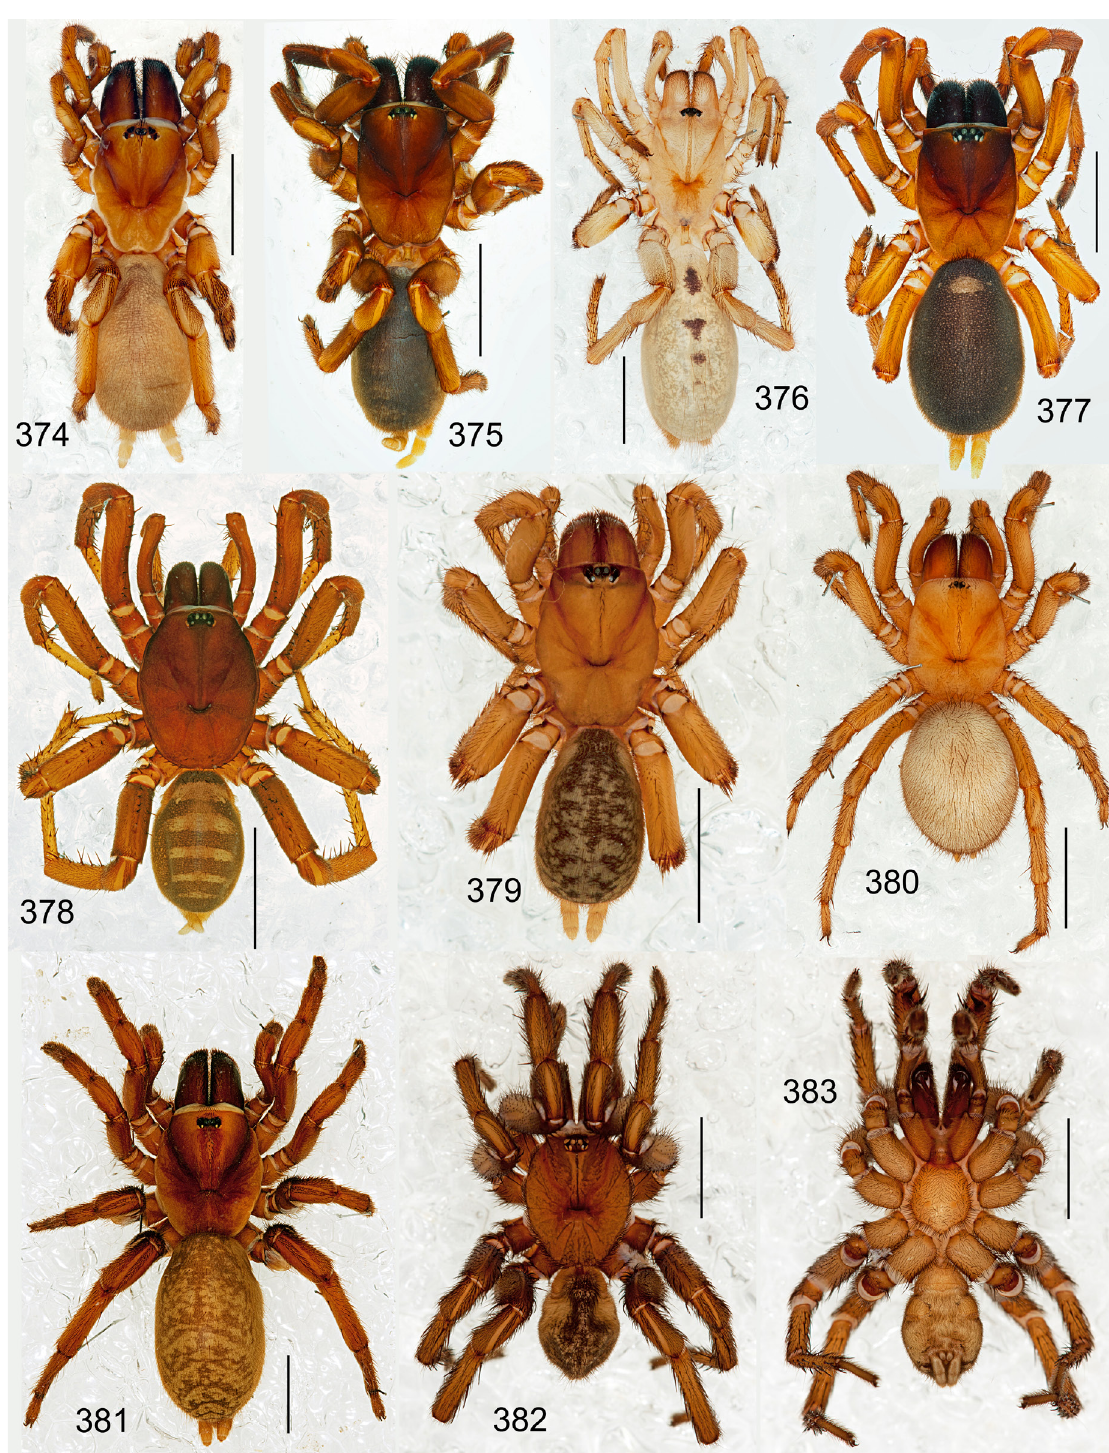
Figs 374–383. Mygalomorph spiders, members of Cyrtaucheniidae (374–380) and Nemesiidae